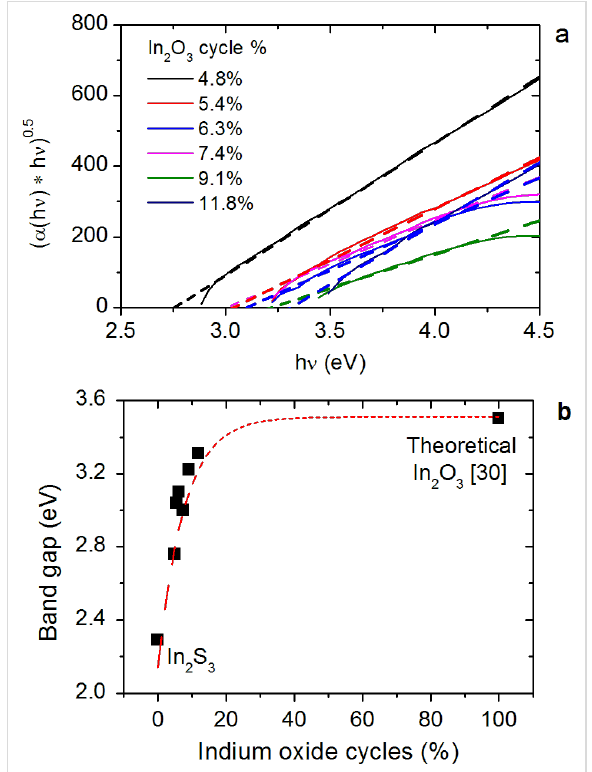
Figure 6: Influence of the number of In 2 O 3 cycles a) on the absorption and b) optical band gap when using O 2 plasma as oxygen precursor. The dotted line is a guide to the